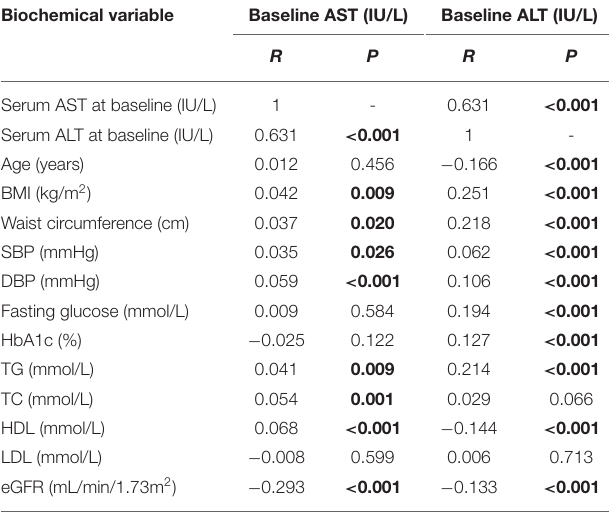
TABLE 3 | Correlation between biochemical variables and baseline AST and ALT. Biochemical